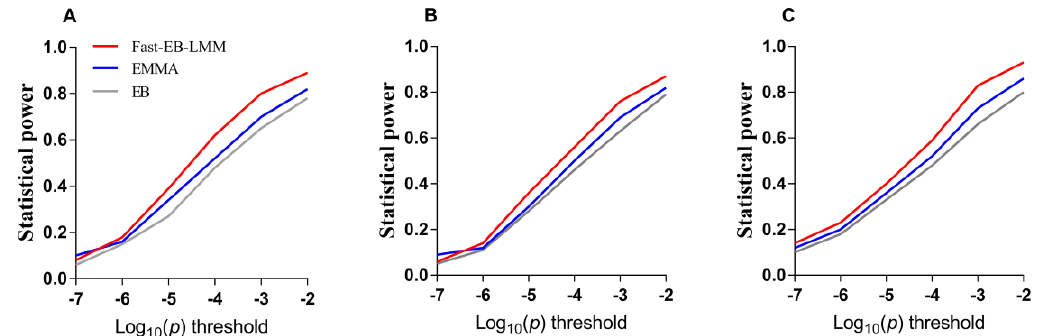
Figure 2. Statistical powers of six simulated QTNs from the first simulation experiment plotted against Type 1 error (in a log10 scale) for the three GWAS methods (Fast-EB-LMM, EMMA and EB). ( A ) No polygenic background. ( B ) With polygenic background. ( C ) With epistatic background.